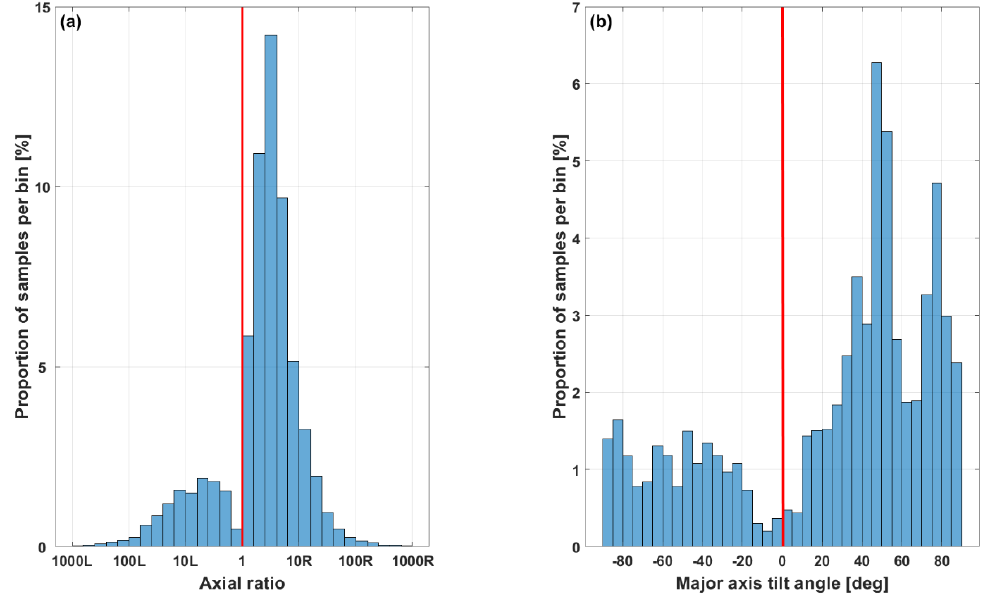
Figure 8. Sardinia (Italy): 8 August 2018, total 8.4 min at 6000 samples s − 1 . ( a ) Axial ratio histogram. Horizontal axis: axial ratio (logarithmic scale). Red center line: axial ratio = 1 (circular polarization). Left of center line: left-hand elliptical polarization. Right of center line: right-hand elliptical polarization. Vertical axis: proportion of samples per bin. ( b ) Tilt angle histogram. Horizontal axis: tilt angle (linear scale). Red center line: tilt angle = 0° (horizontal). Left of center line: negative tilt angle. Right of center line: positive tilt angle. Vertical axis: proportion of samples per bin.